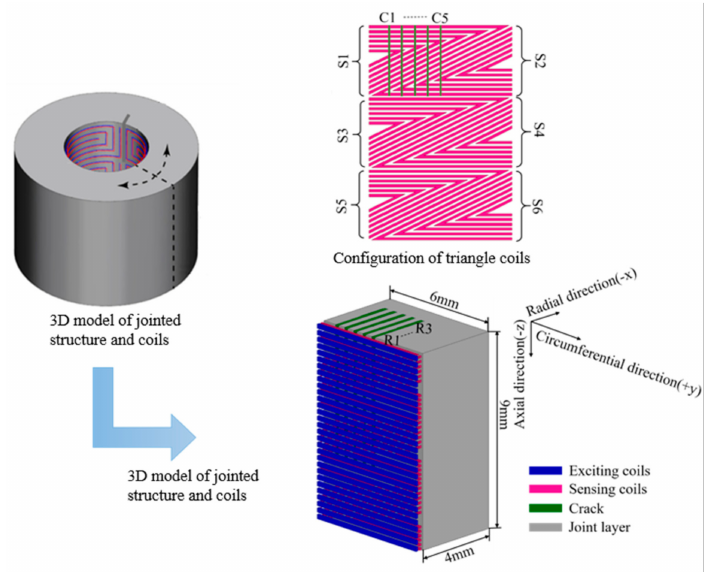
Figure 3. The simulation